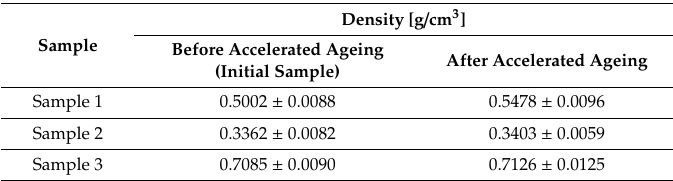
Table 3. Density of